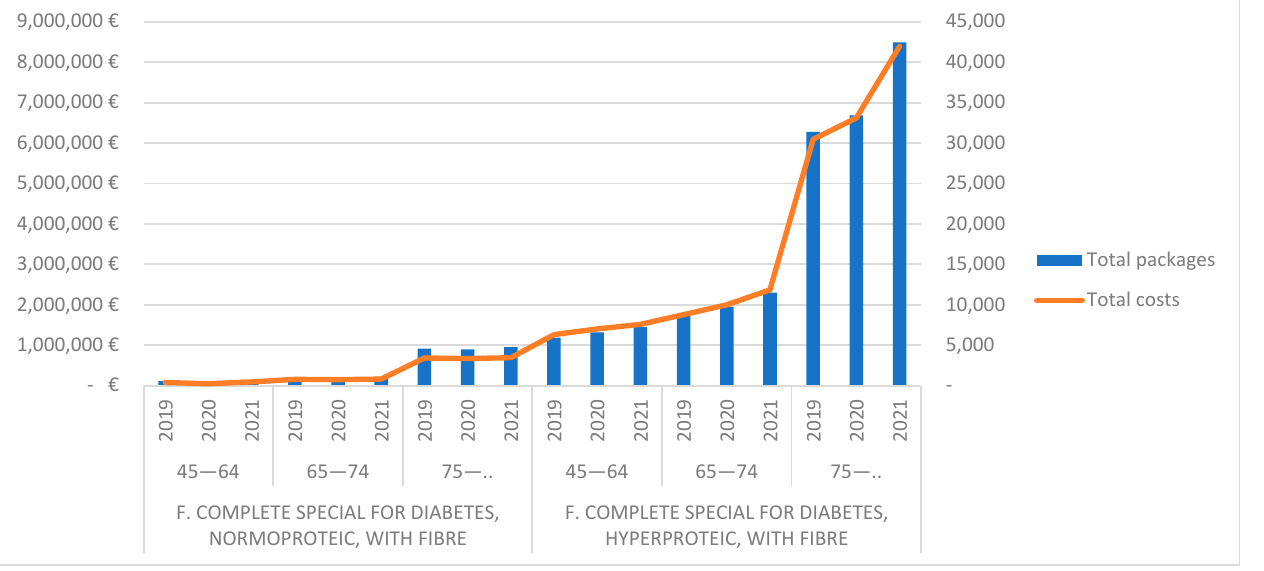
Figure 5. Number of total packs consumed and expenditure on diabetic dietary therapies from 2019 to 2021 in age groups from 45 years in the Community of Madrid.